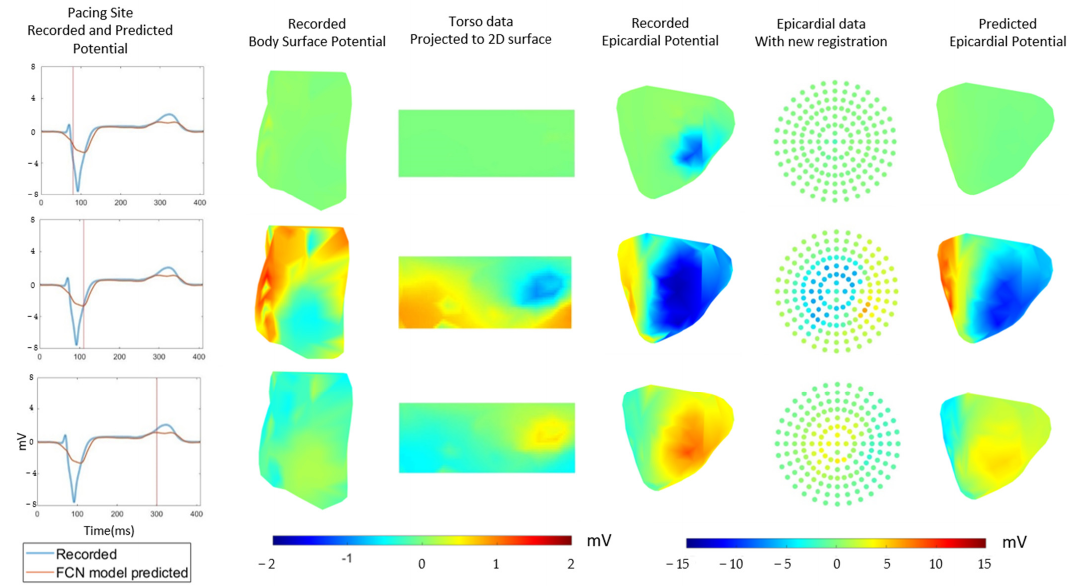
Figure 10. Example of visualizing the potential. The figure shows the potential in three time steps from top to bottom. First column: Electrogram of the recorded and predicted potential. The vertical red line indicates the time step. Second column: Visualization of the torso’s potential. Third column: Potential from the torso lead’s recording after 2D transformation. Fourth column: Visualization of the epicardial potential. Fifth column: Epicardial node potential after transformation into a template. Sixth column: Visualization of the reconstructed epicardial potential.